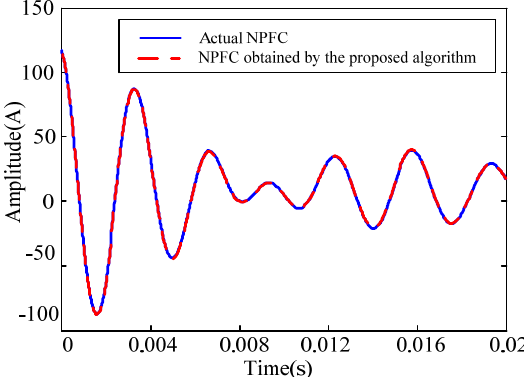
Figure 3. Comparisons for two calculated non-power frequency components (NPFCs).